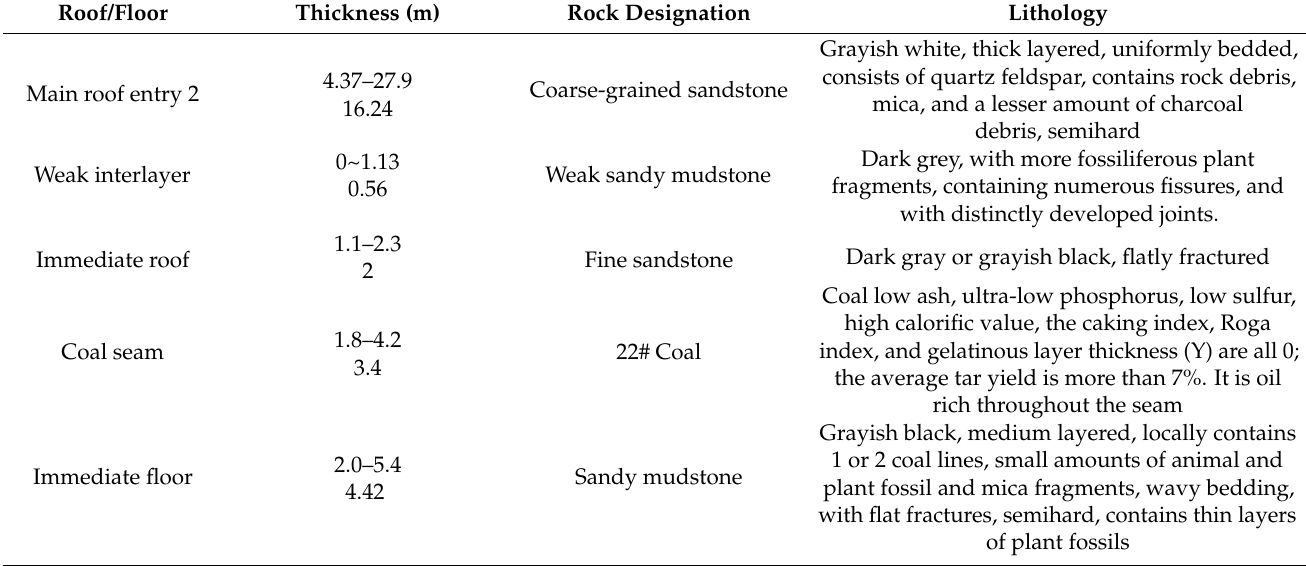
Table 1. Characteristics of the coal roof and floor strata.